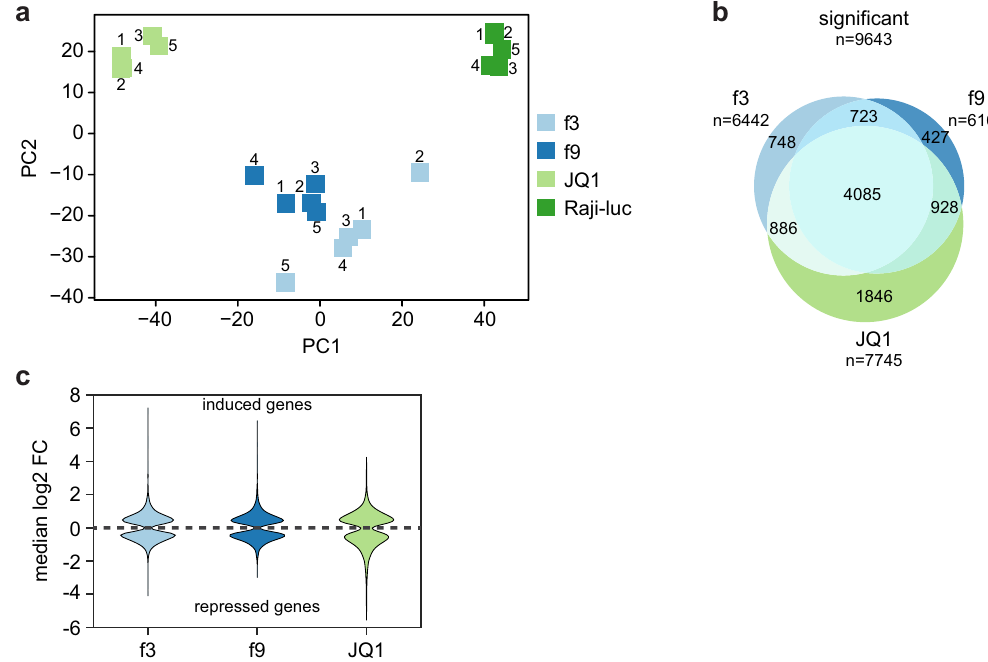
Figure 3. Analysis of transcriptomes JQ1-treated Raji cells and dnBrd4 mutants f3 and f9. ( a ) Principal component analysis of 20 RNA-seq samples; 5 replicates per condition. f3 replicate no. 2 did not cluster properly with the other f3 replicates and was excluded from further analysis (see also Supplemental Fig. 5). ( b ) Significantly (p-value: ≤ 0.05) differentially expressed genes of f3, f9 and JQ1-treated Raji cells were plotted as Venn diagram to visualize commonly regulated genes. ( c ) Distribution of median log2 fold-change for DE genes. Induced genes were plotted above the dashed line, reduced genes below. Median log2 FCs were calculated using the log 2 FC values determined by the differential expression programs that found a statistical significant change (at least 2 out of limma, edgeR,